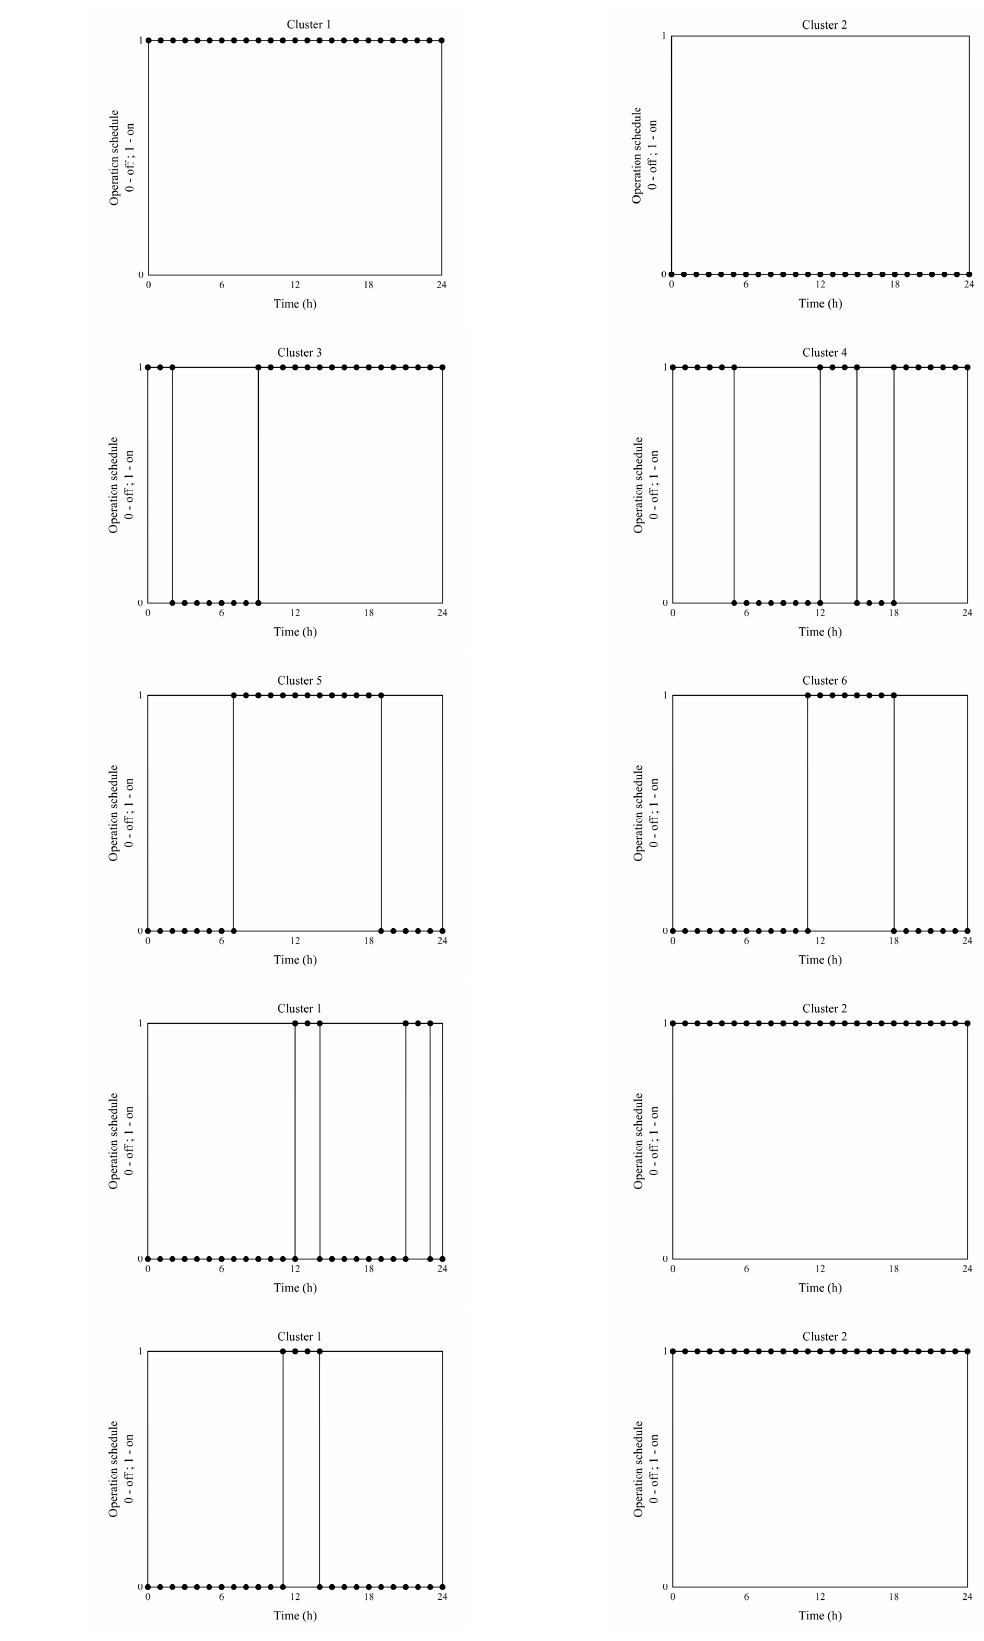
Figure 8. AAHP heating pattern schedules for different heating periods in Hebei’s bedrooms. For the bedroom, during the early heating period, Cluster 1 is the most common heat- ing pattern of the AAHP (accounting for 50%), representing a continuous heating pattern of turning on the AAHP all day. There is a total heating duration of 24 h in Cluster 1. However, the heating pattern in Cluster 2 (18%) represents no heating demand, and the AAHP is always off. Cluster 3 represents the “before dawn-off user” and Cluster 4 the “morning and afternoon-off user”. These two heating patterns accounted for a total usage